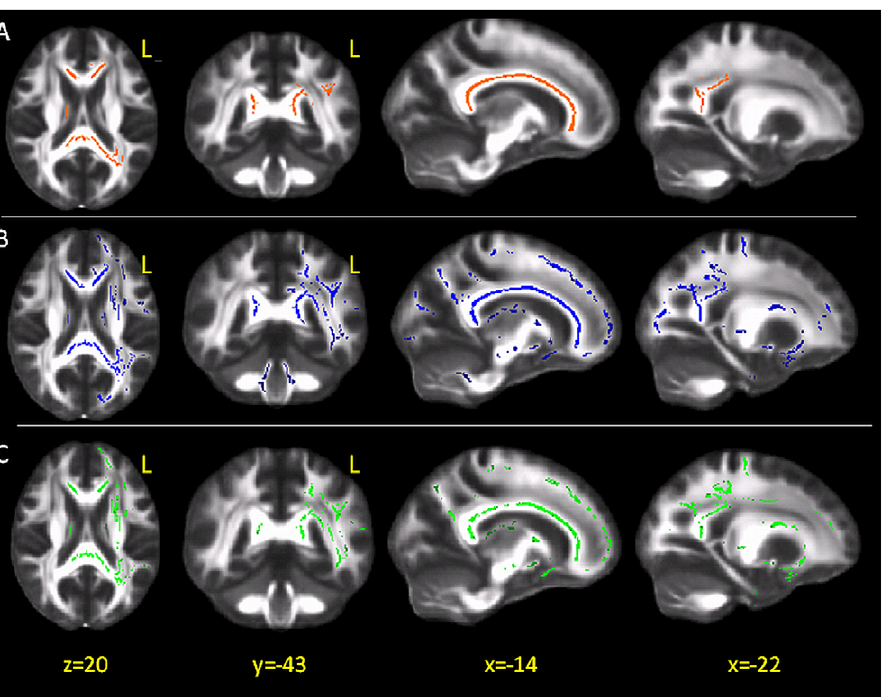
Figure 2. TBSS results in patients vs. controls: fractional anisotropy; radial diffusivity, and mean diffusivity. (A) Red voxels represent the areas where fractional anisotropy (FA) values of patients are significantly reduced with respect to those of healthy controls, overlaid onto the group-averaged FA image. FA values are significantly reduced in the corpus callosum and its projections on the parietal white matter. (B) Blue voxels indicate the areas of increased radial diffusivity in patients. The same sections as in panel A are shown to ease the comparion with FA results. (C) Green voxels indicate tracts where MD was increased in patients. Again, the same sections as in panels A and B are shown. L=left; x,y,z, indicate the MNI coordinates.